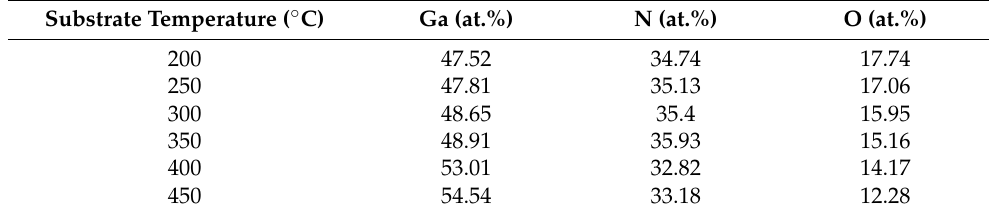
Figure 8. O 1s XPS spectra for the PEALD GaN films deposited at ( a ) 200, ( b ) 250, ( c ) 300, ( d ) 350, ( e ) 400, and ( f ) 450 ◦ C. Table 2. Ga, N, and O atomic ratios for the GaN films prepared at different substrate temperatures. Substrate Temperature ( ◦ C) Ga (at.%) N